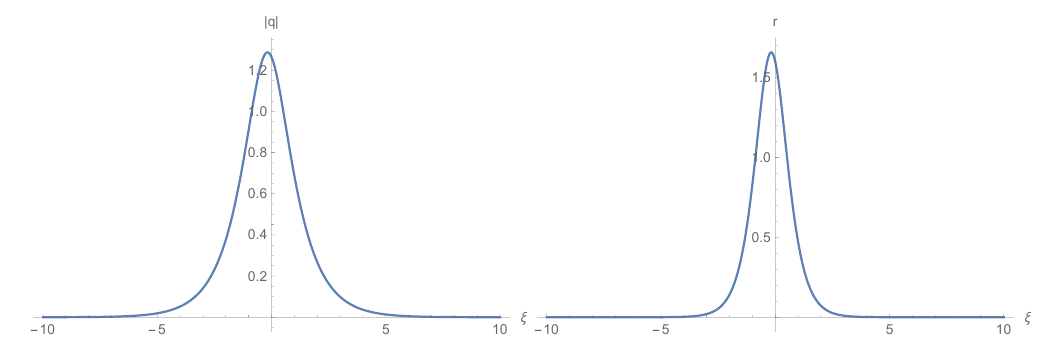
Figure 1. A one-soliton solution given by a one-fold Darboux transformation.